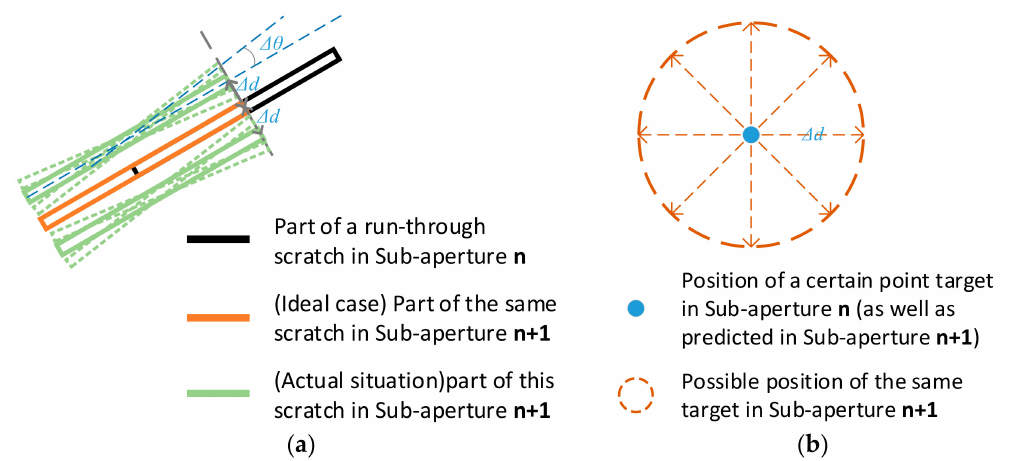
Figure 10. Description of mismatches for scratch and digs situation. ( a ) Mismatch of long run-through scratches between consecutive sub-apertures; ( b ) Possible dislocation of the same point targets between consecutive